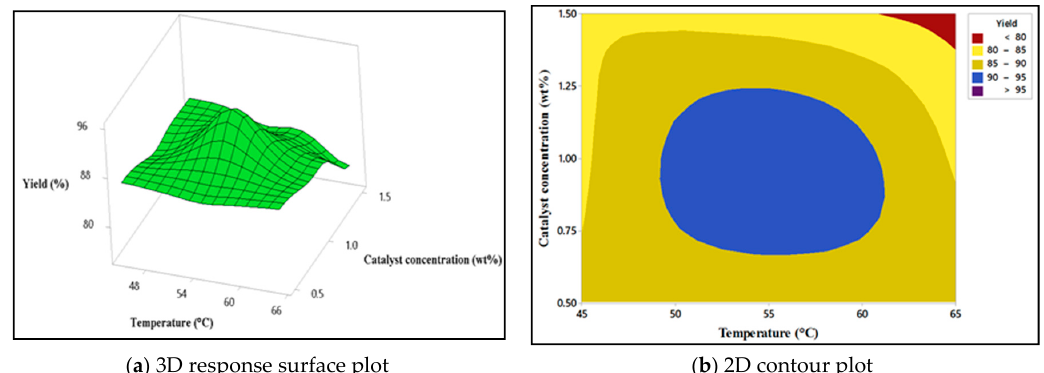
Figure 7. Interaction effect of reaction temperature (T) and catalyst concentration (C) on SFO biodiesel yield.